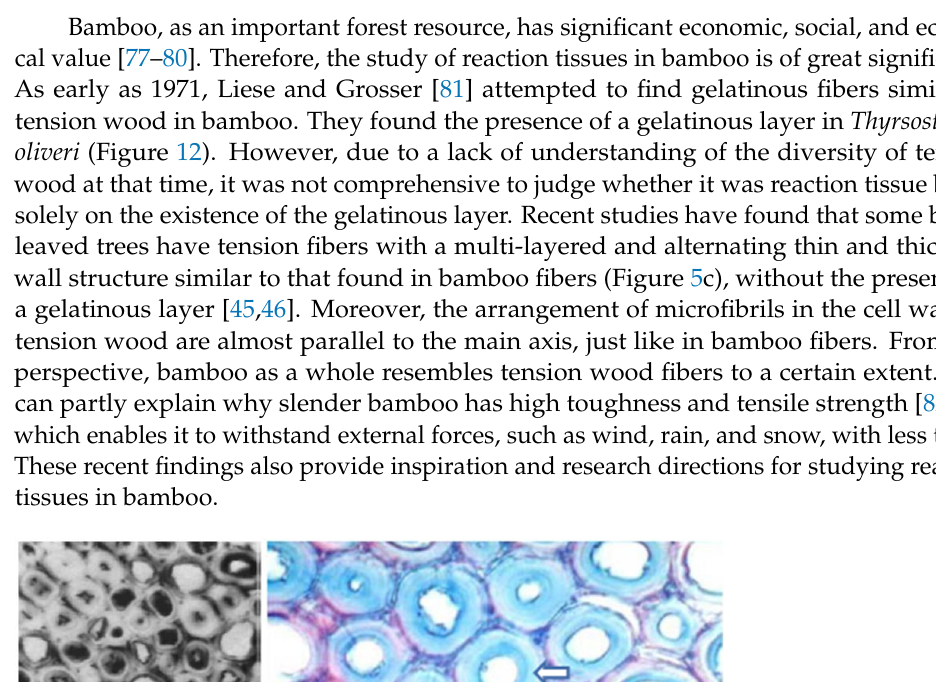
Figure 11. ( a ) Gelatinous fibers produced in primary and secondary phloem of Cannabis sativa stem and ( b ) phloem of Linum usitatissimum stem [11]. C: cambium; E: epidermis; Gf: gelatinous fibers; Ph: phloem; X: xylem.